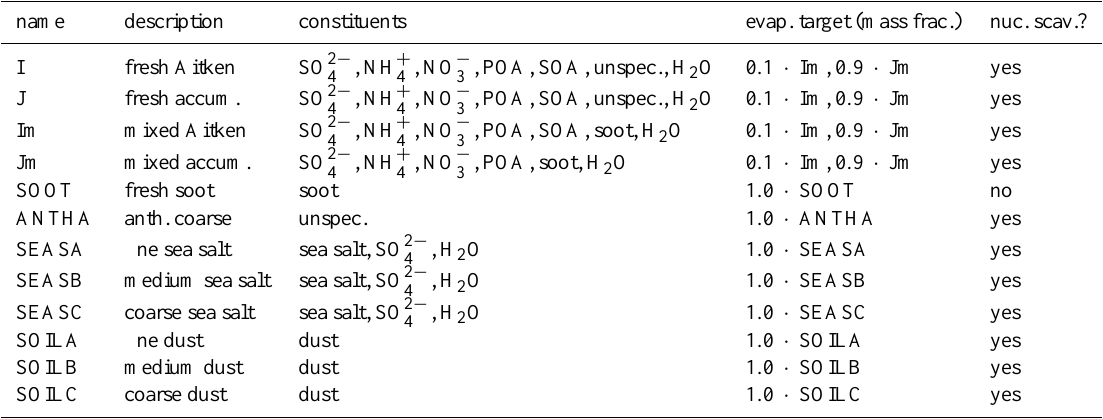
Table 1. Aerosol modes in COSMO-ART, their constituents, targets for release upon droplet evaporation, and whether the mode participates in nucleation scavenging.